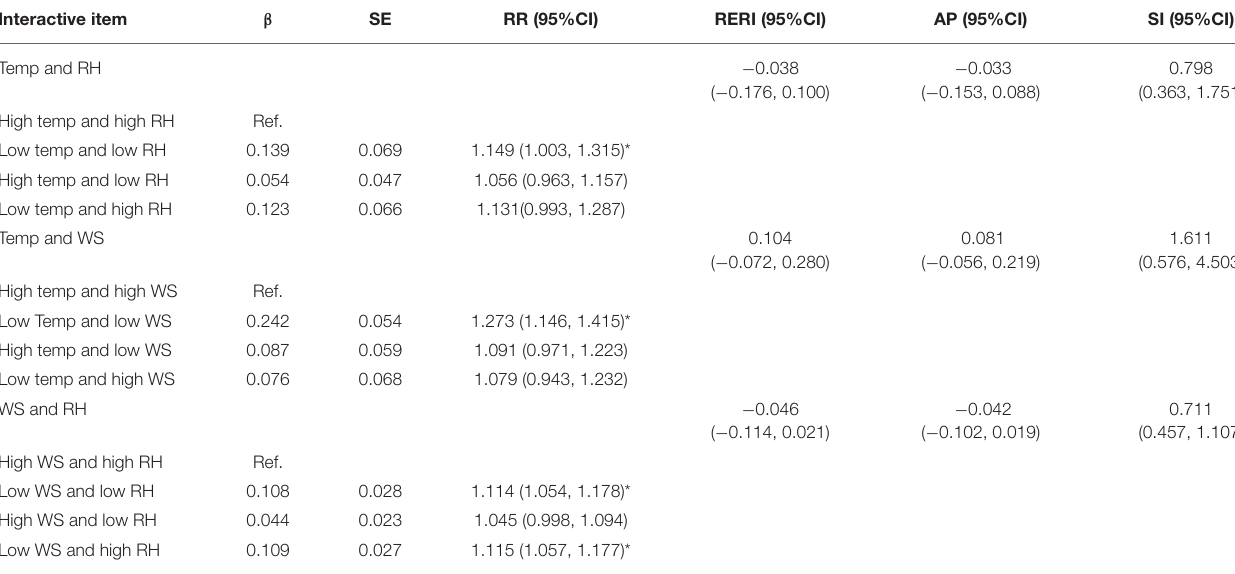
TABLE 5 | Effects of different interaction items on the incidence of